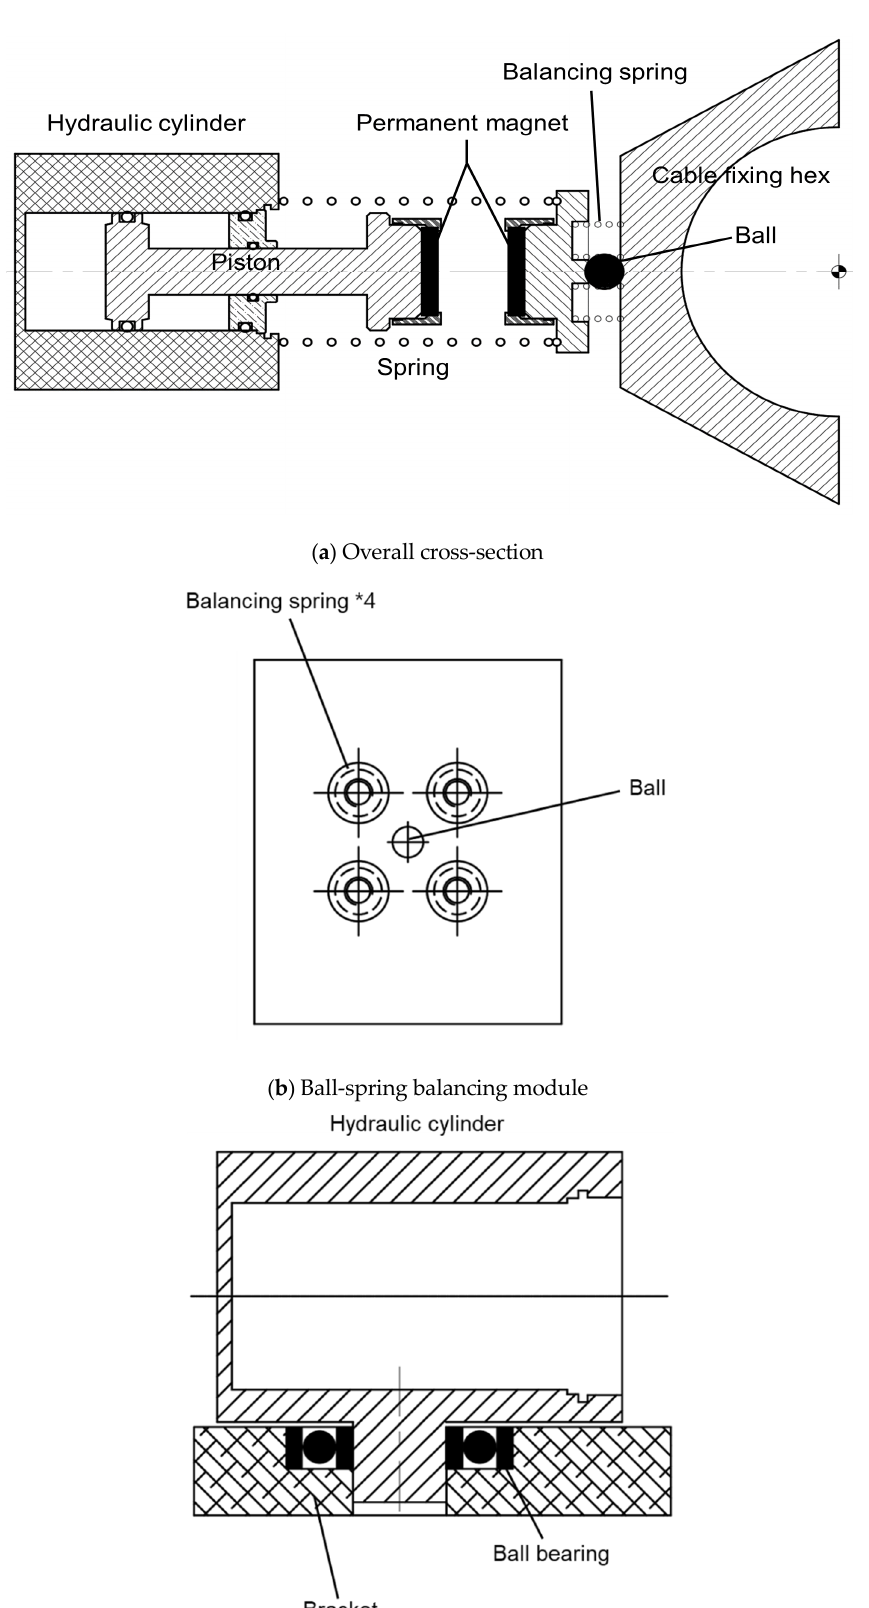
Figure 2. Internal configuration of 1/6 piece of VEAM.